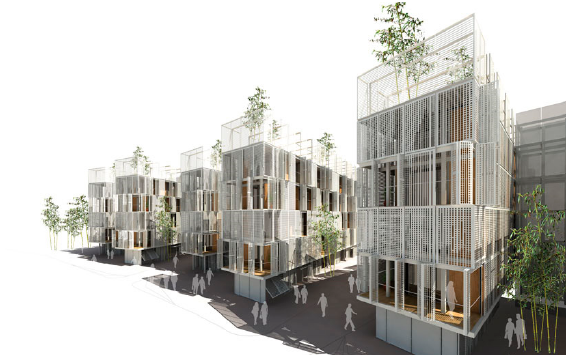
Figure 13. SymHouse by Piercy Conner, United Kingdom, Living Steel International Architecture, India, 2005 [24].